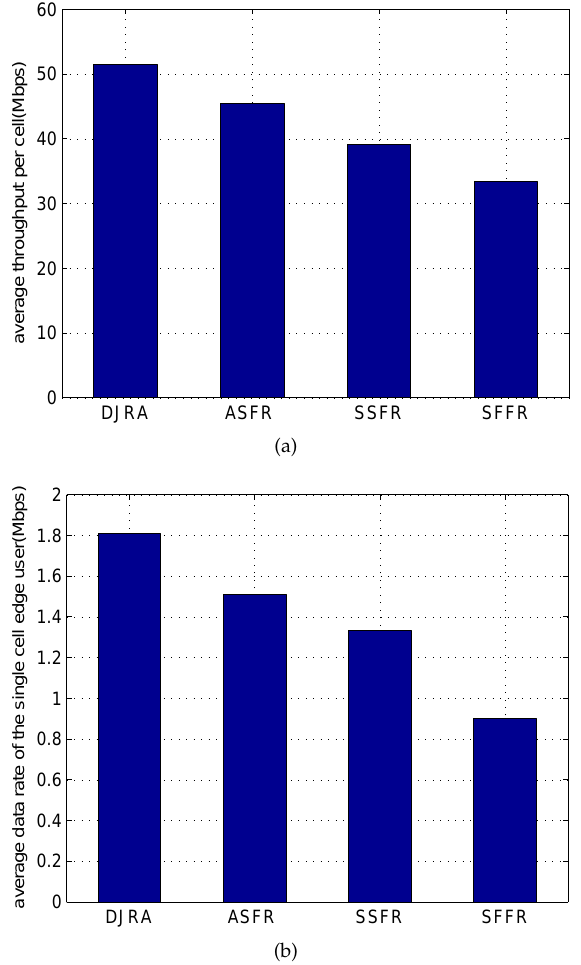
Figure 6. ( a ) Average throughput for a single cell ( b ) Average data rate for a